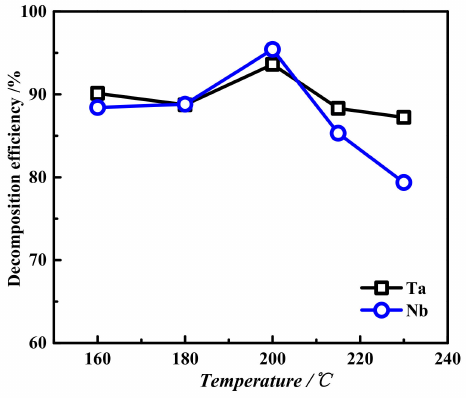
Figure 9. The effect of different temperatures on the decomposition efficiencies of tantalum niobium: basicity 40 wt.%, liquid–solid ratio 4:1, oxygen partial pressure 2.5 MPa, and reaction time 2 h.